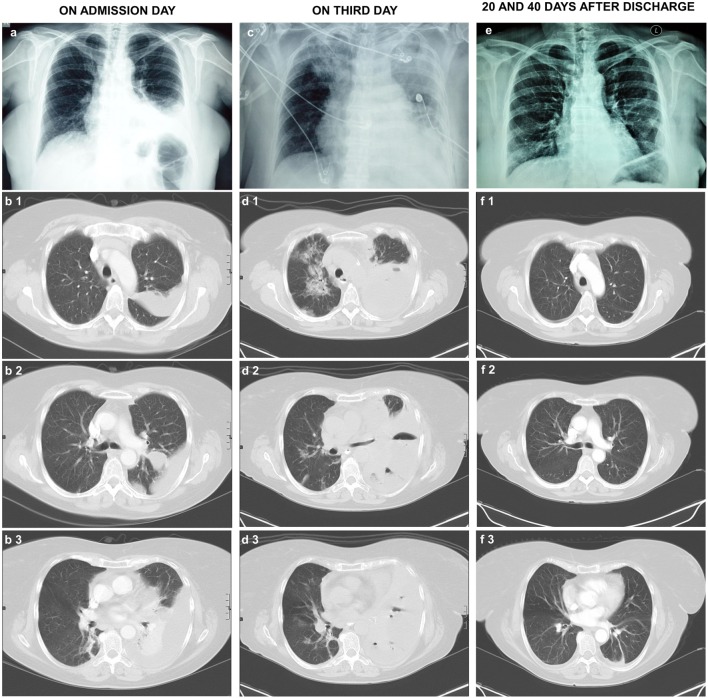
(A) CXR and (B1–B3) CCTs with intravenous contrast material on the admission day exhibit left-sided pleural fluid with consolidation and atelectasis of the left lower lung field. (C) CXR and (D1–D3) CCTs on the third day of admission. They exhibit significant increase of the left-sided pleural effusion with compressive atelectasis of the left lung and development of extensive consolidations in the right lung, especially in the upper lung fields. Small air collections are present in the pleural fluid. The chest drainage tube can be seen on the left of the CXR. (E) CXR 20 days and (F1–F3) CCT 40 days after the patient discharge from the hospital. They show complete resolution of the lung consolidations, limited left pleural thickening, and minimal pleural fluid (1: upper lung fields, 2: middle lung fields, 3: lower lung fields). CXR, chest X-ray; CCT, chest computerized tomography.